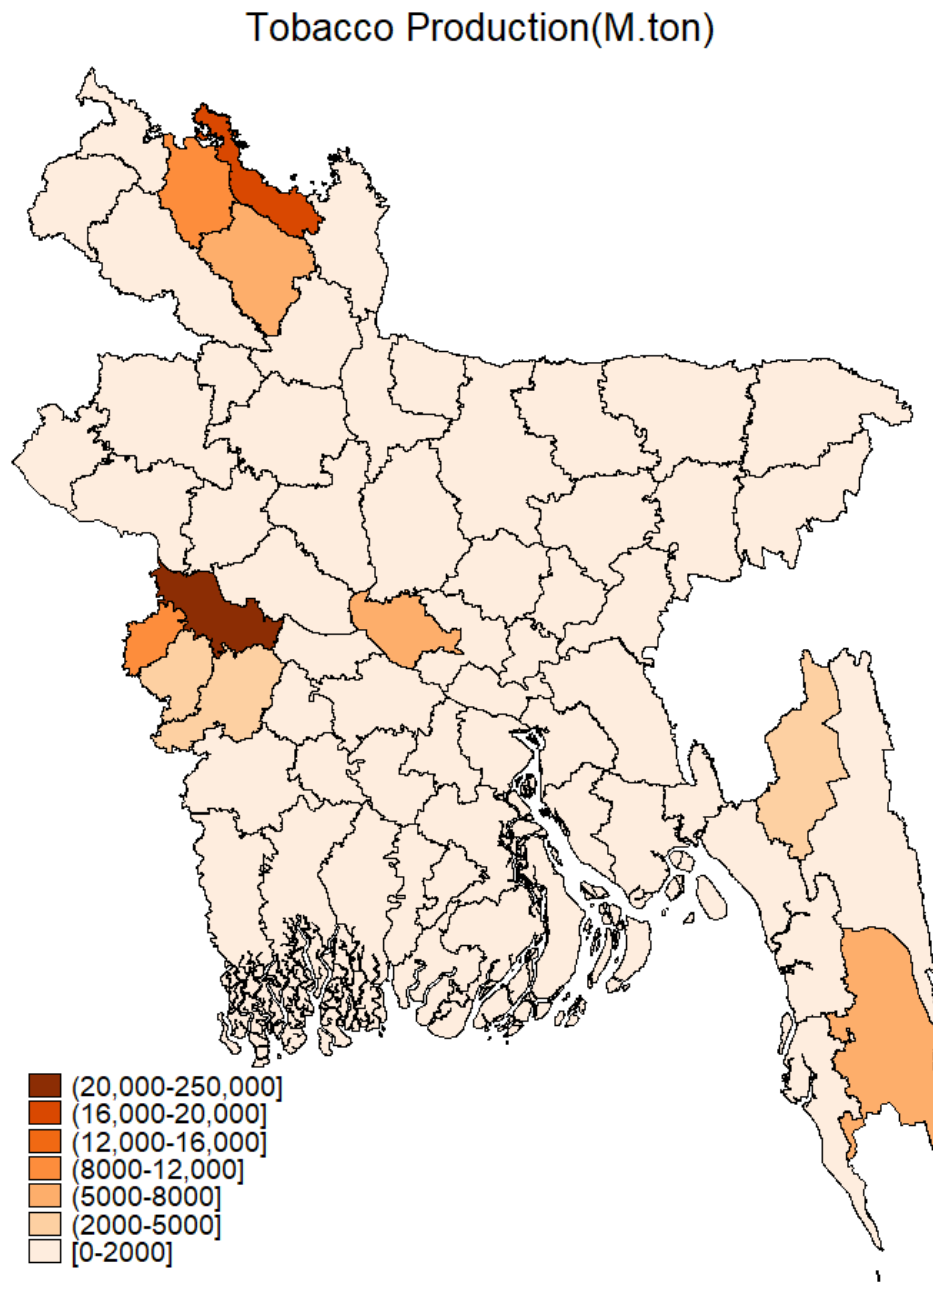
Figure A2. Tobacco Production (M. ton): 2017–2018. Source: Agricultural Yearbook, BBS (2018).